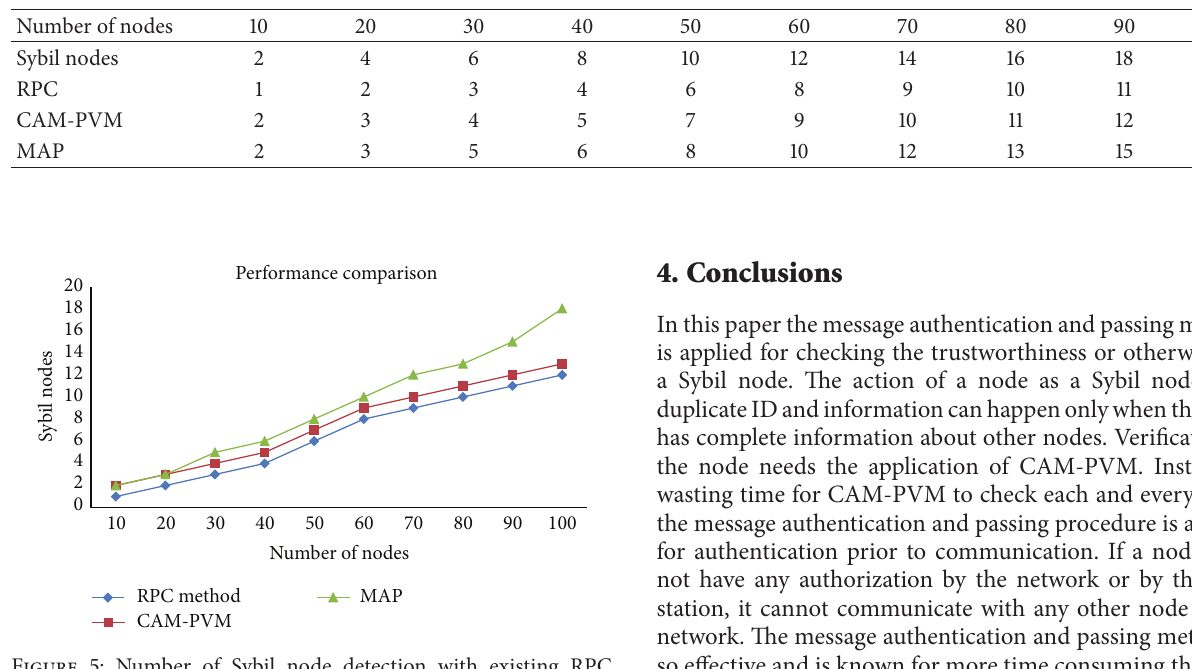
Figure 5: Number of Sybil node detection with existing RPC method with proposed between CAM-PVM and MAP.